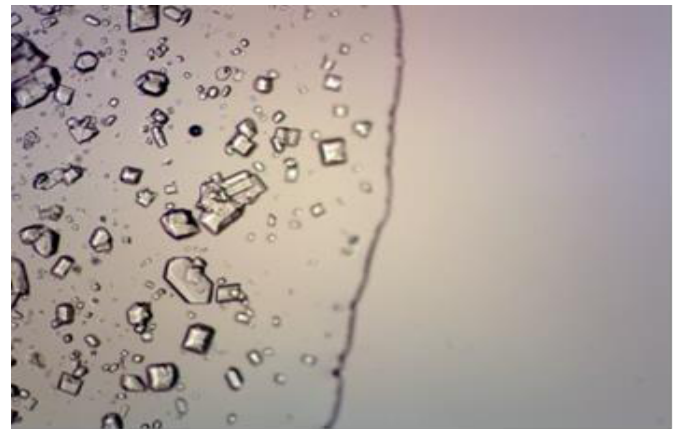
Figura 5: Solución a 69° Brix. Fuente: Los autores, (2018).